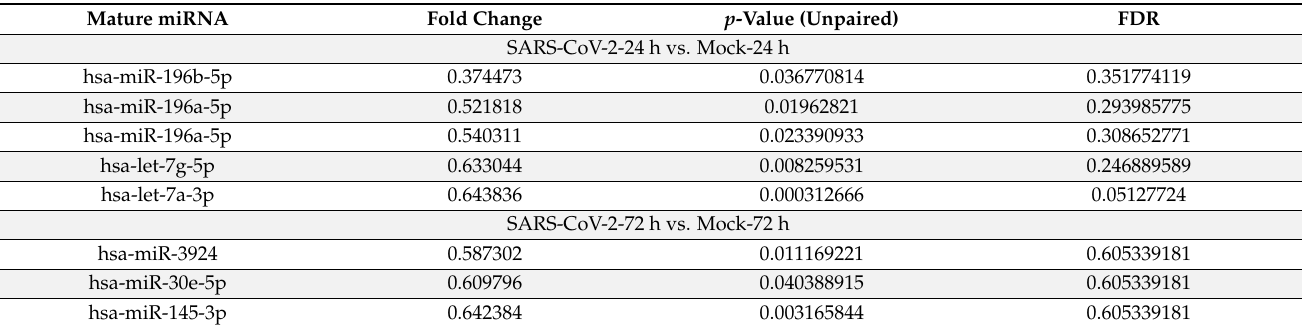
Table 2. Top 10 downregulated miRNAs in Calu-3 cells at 24 h and 72 h post-SARS-CoV-2 infection, compared with uninfected control (Mock). No other miRNAs meeting the criteria other than the ones listed in this table were identified. Therefore, the top 10 does not contain 10